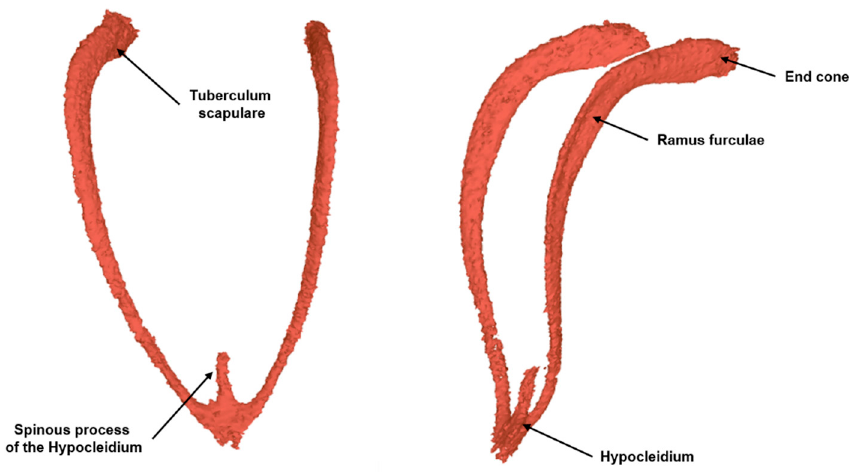
Figure 6. Three-dimensional reconstruction of the furcula of the Ardea purpurea glacier